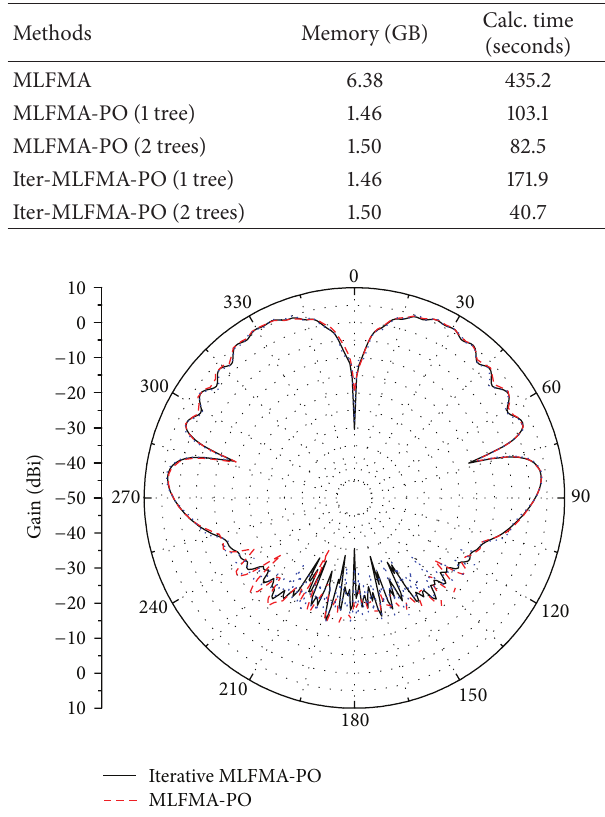
Table 1: Calculation time and memory requirement of different methods for the monopole mounted on a plane.